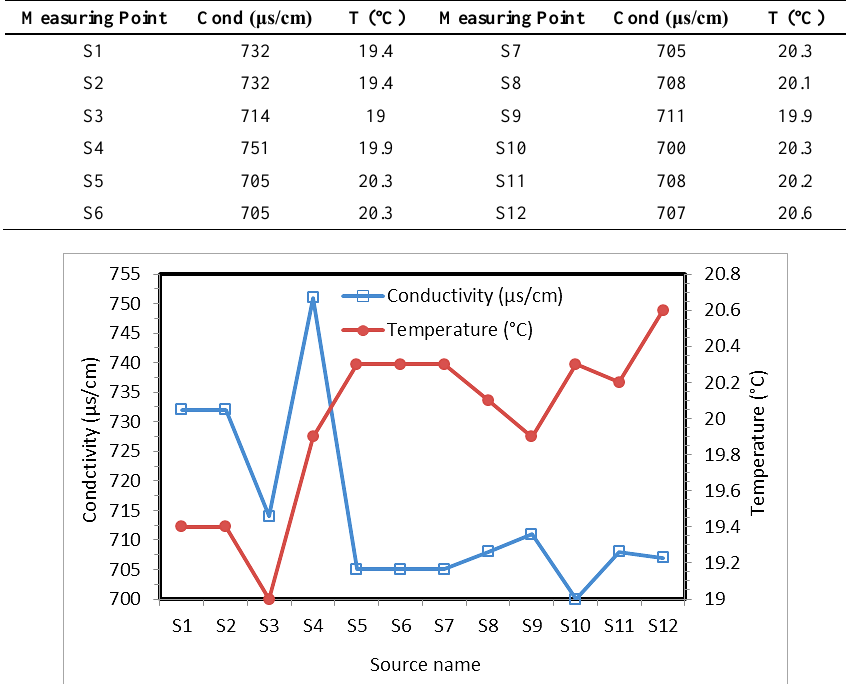
Table 1. Conductivity and temperature results at resurgences located downstream of the dike